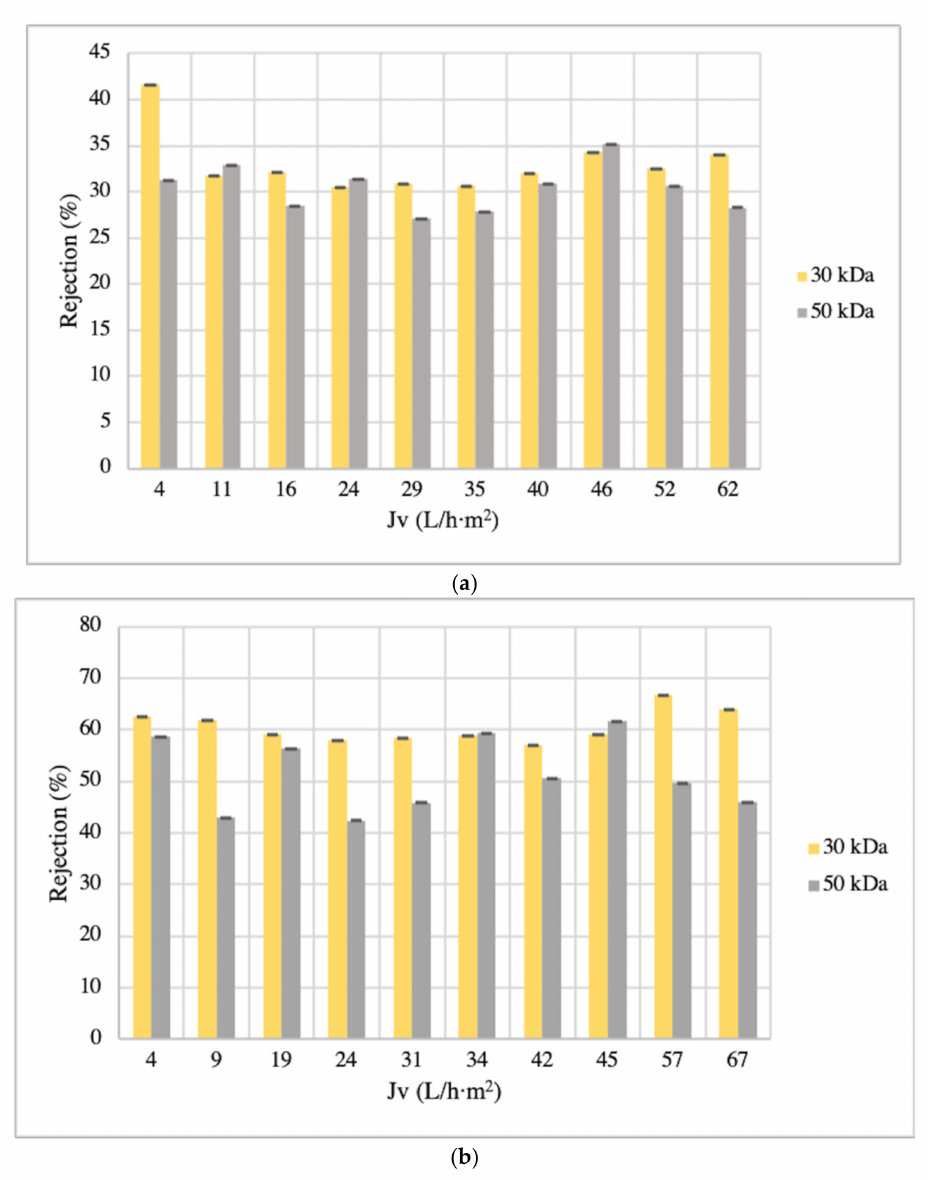
Figure 3. UF (30 and 50 kDa) rejection evolution with permeate flux of spinach and orange matrices (( a , b ),